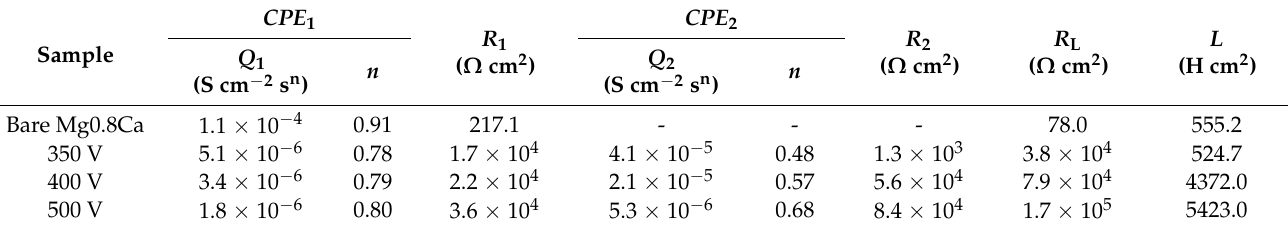
Table 3. Parameters of the EECs elements.